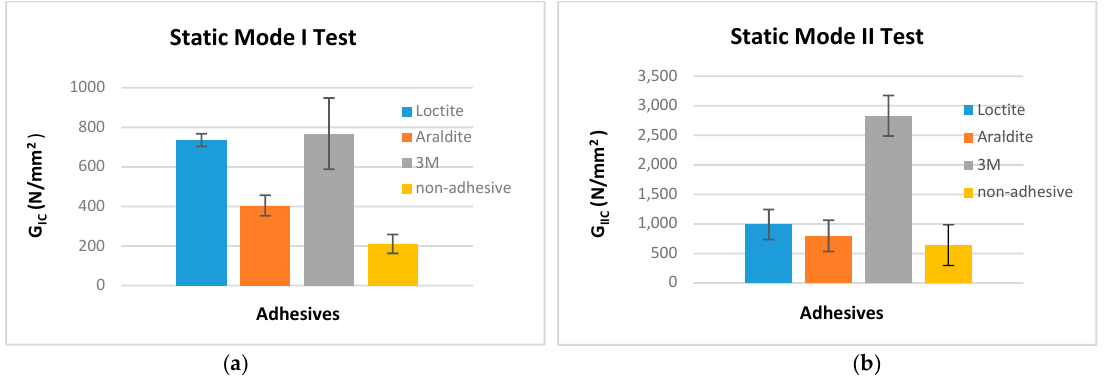
Figure 2. Interlaminar fracture toughness of the different adhesives used. ( a ) for mode I and ( b ) for mode II.